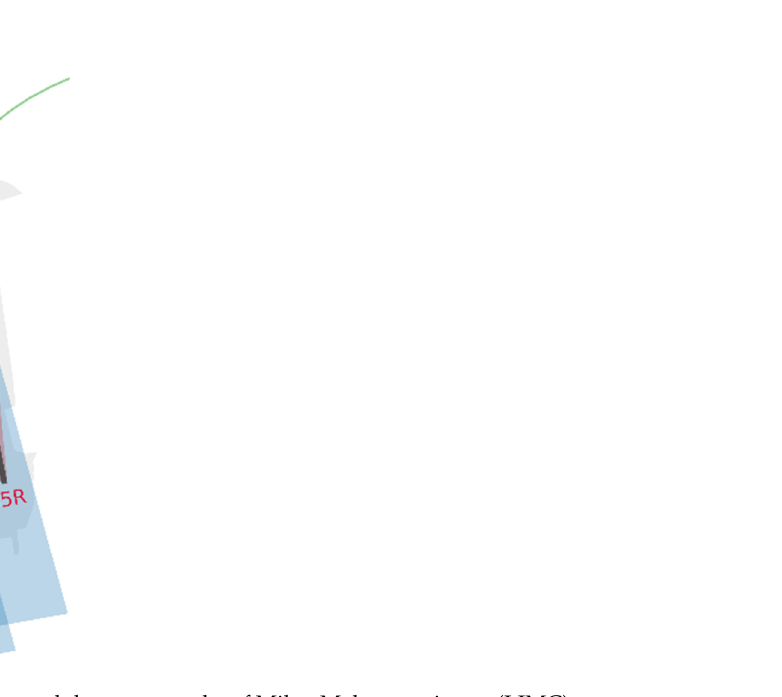
Figure 5. Runways and departure paths of Milan Malpensa airport (LIMC).